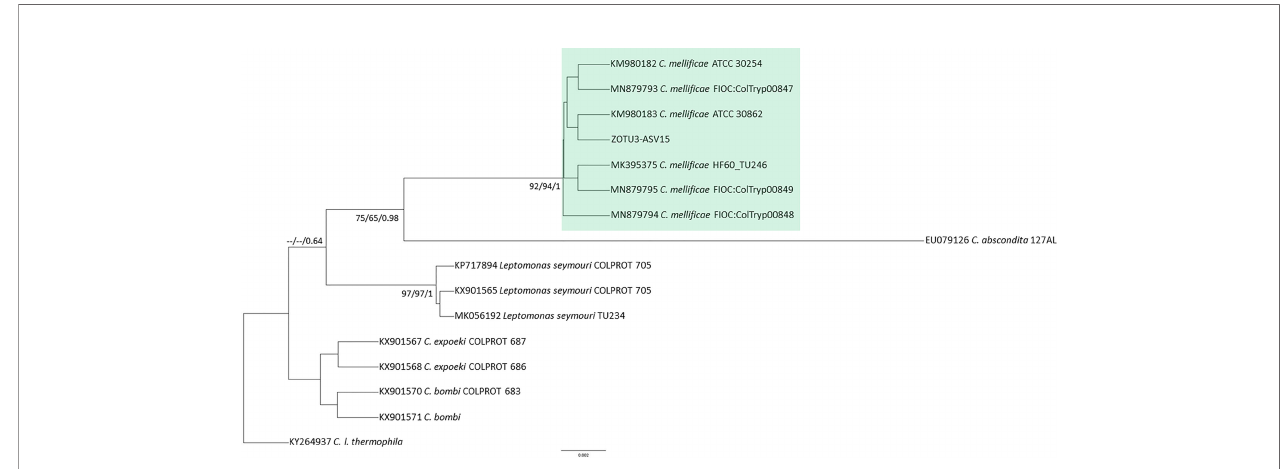
FIGURE 3 | Crithidiamelli fi cae phylogenetic tree based on333bp 18S rDNA fragment length from R. rattus hemoculture sample. The tree was inferred with Bayesian using Tamura-Nei with equal frequencies (TrNef) model for MLand BI. The number at nodes corresponds to ML (ultrabootstrapand SH-aLRT) andBI (posterior probability). The scale bar shows the number of nucleotidesubstitutionsper site. The green square indicates the group formed by C. melli fi cae sequences from different hosts.